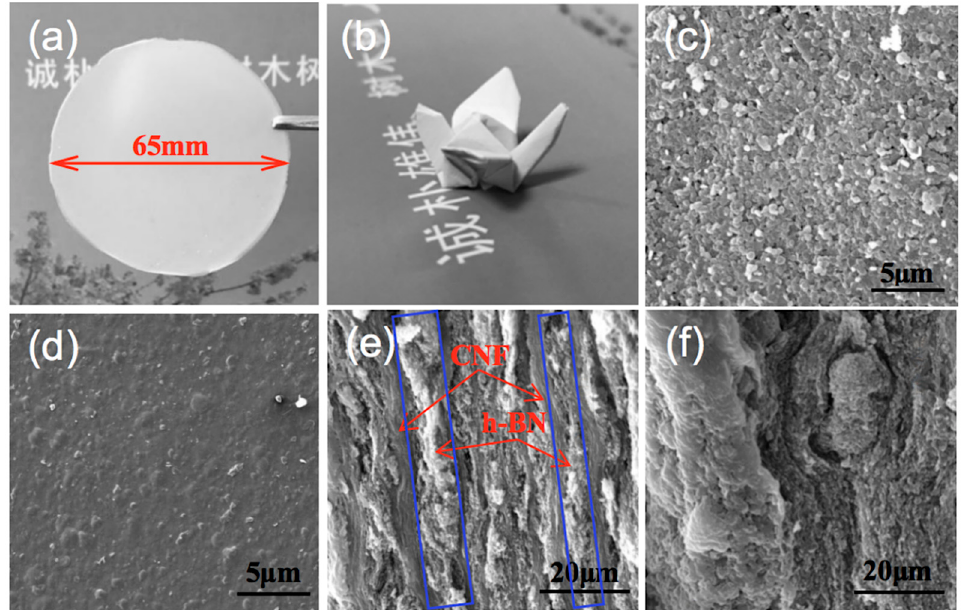
Figure 3. ( a ) Optical photograph of h-BN/CNF aerogel perfusion composite film with 23.08 wt % h-BN loading, red arrow indicated the diameter of the film was 65 mm. ( b ) Optical photograph of a “paper crane” folded from a h-BN/CNF aerogel perfusion composite film. ( c , d ) Surface SEM images of h-BN/CNF aerogel perfusion composite film and h-BN/CNF blended composite film with 23.08 wt % h-BN loading, respectively. ( e , f ) Cross-sectional SEM images of h-BN/CNF aerogel perfusion composite film and h-BN/CNF blended composite film with 23.08 wt % h-BN loading, respectively, red arrows were channels of CNFs and h-BN, blue rectangles were thermally conductive pathways of h-BN.